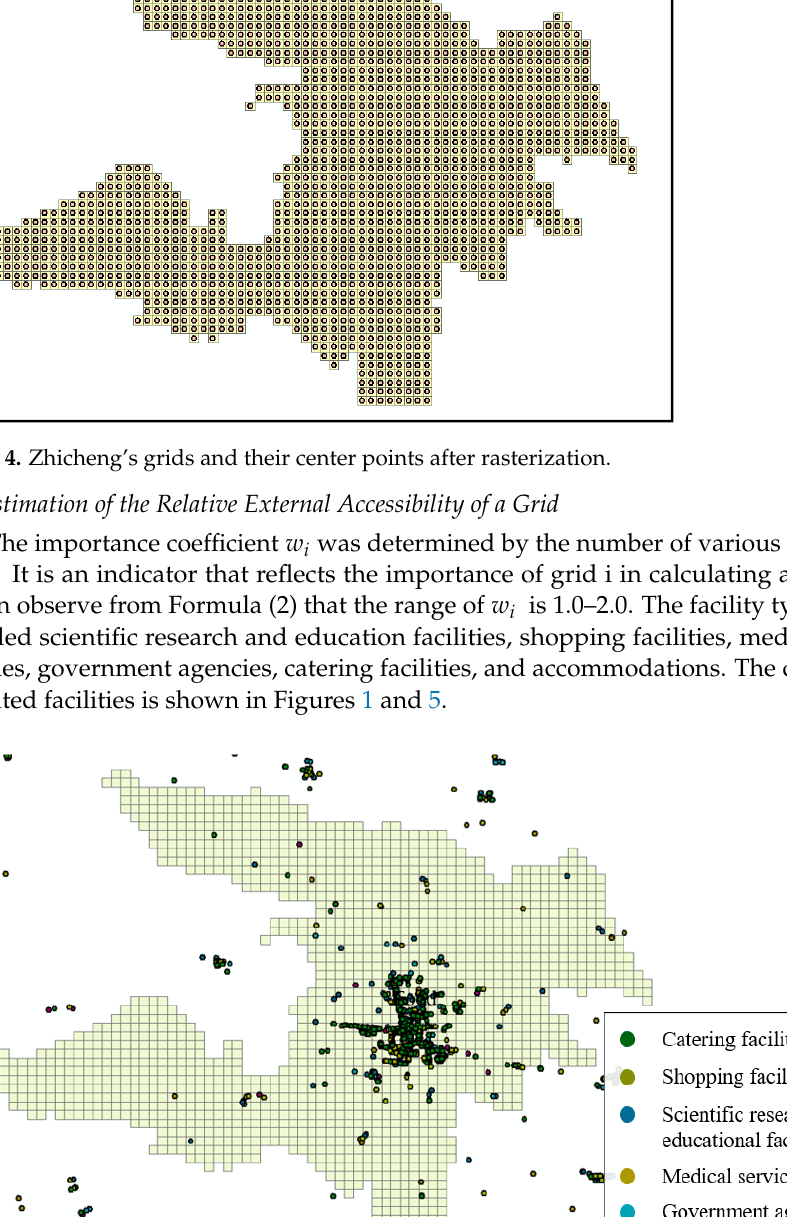
Figure 5. Distribution of related facilities.